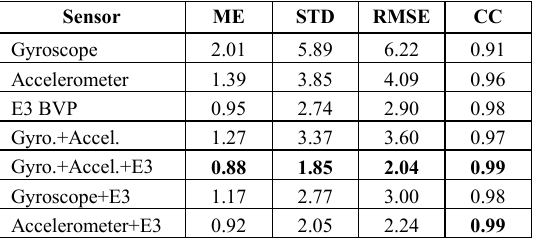
TABLE III. ME OF H EART R ATE ( N :